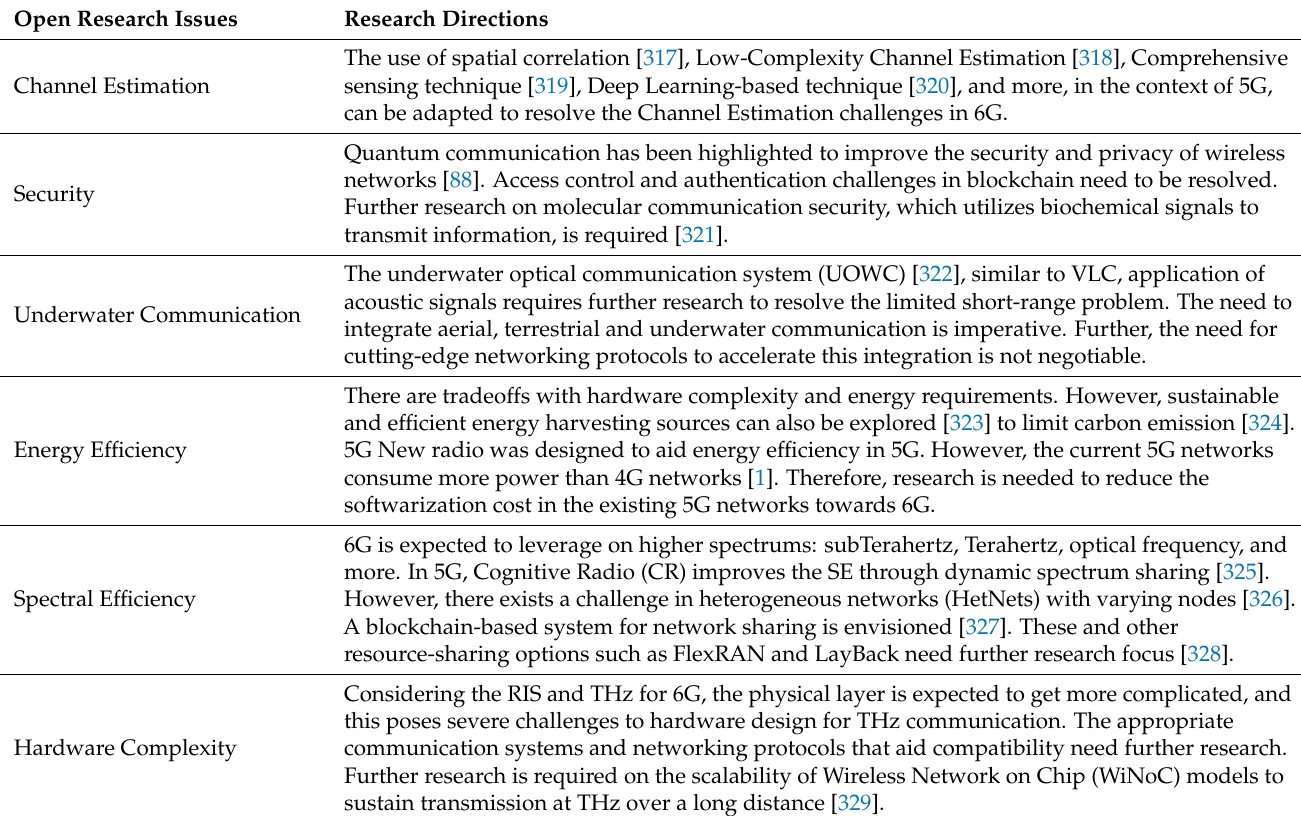
Table 19. 6G related open research issues that require further